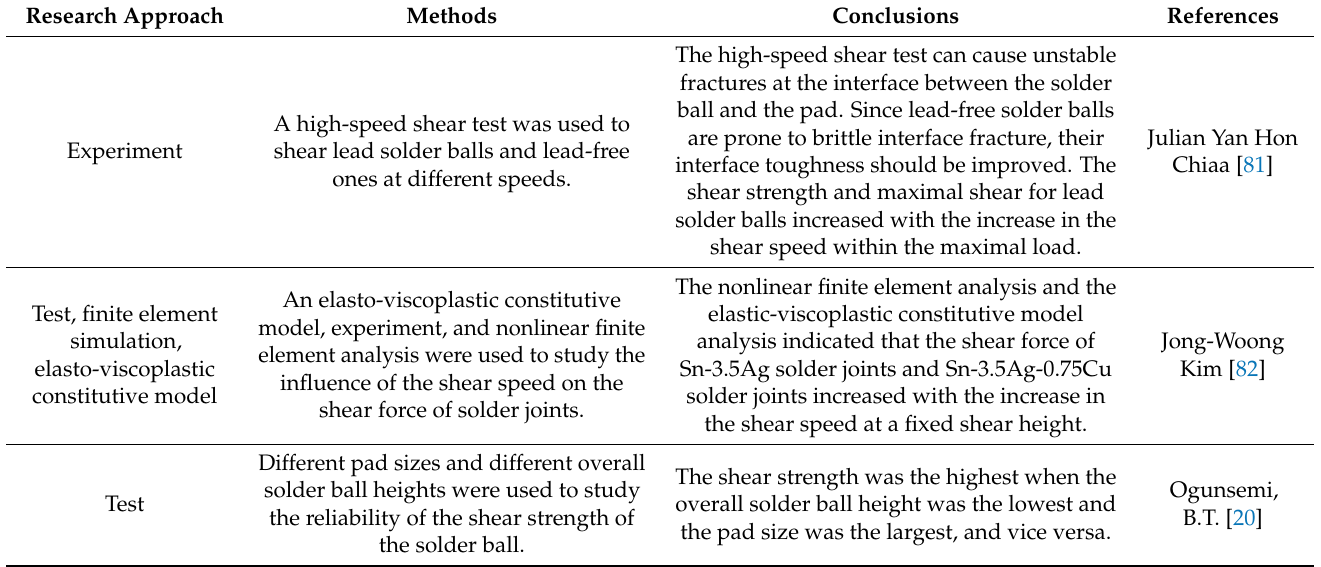
Table 5. Summary of studies conducted under shear